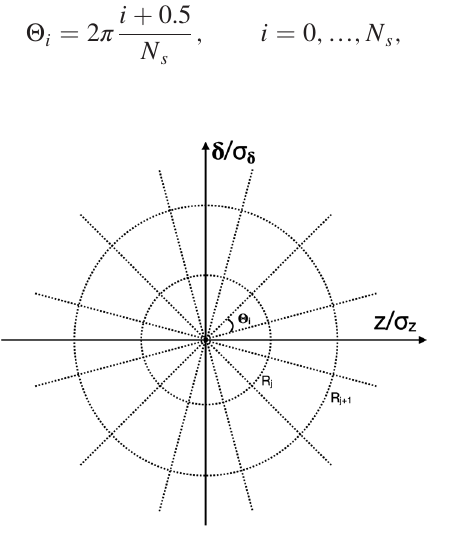
FIG. 2. Illustration of the discretization of the longitudinal phase space in slices and rings within the